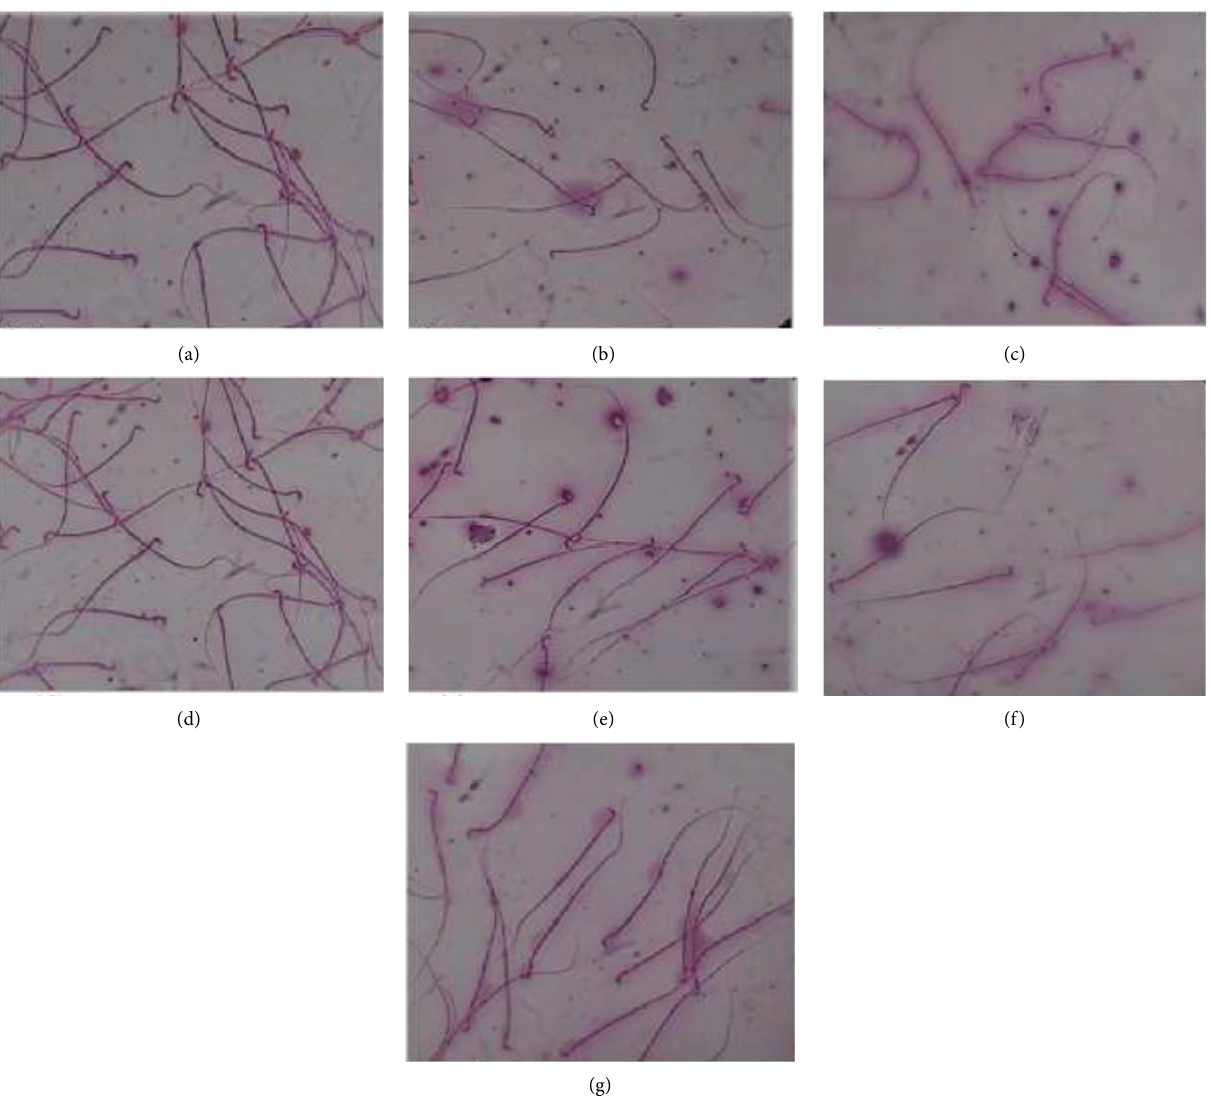
Figure 3: Effect of lycopene, L-carnitine, coenzyme Q10, and zinc sulfate on sperm morphology of cadmium-exposed rats at 100x resolution. (a) Normal control. (b) Disease control. (c) L-Carnitine/coenzyme Q10 treated. (d) Lycopene treated. (e) L-carnitine treated. (f) Zinc sulfate treated. (g) Coenzyme